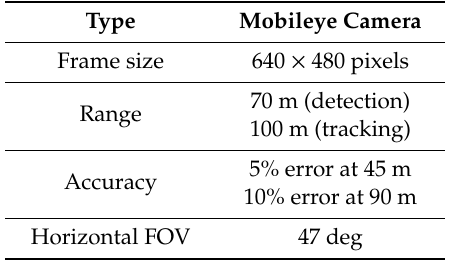
Table 3. Automotive vision sensor specifications.